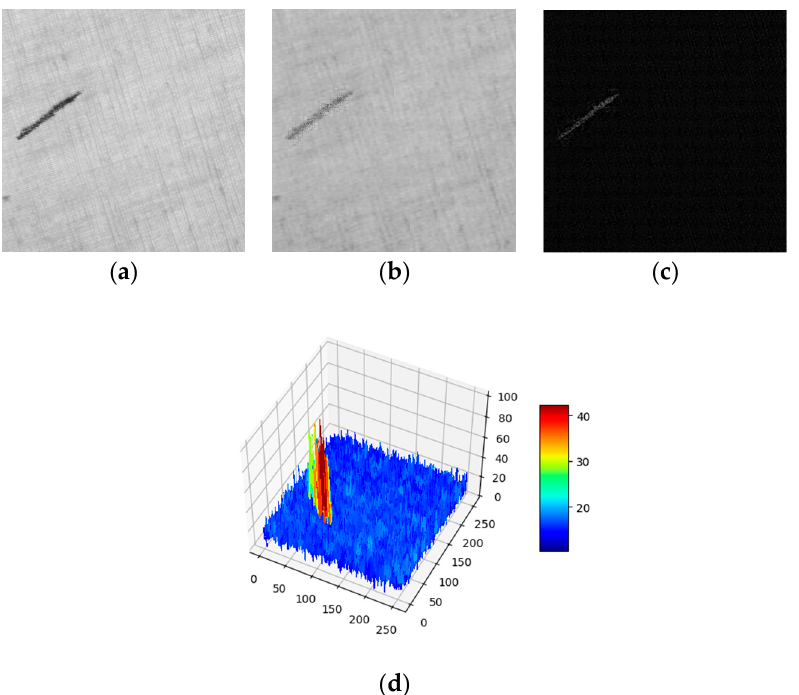
Figure 1. The different reconstruction effectiveness between defective and defect-free regions . ( a ) Original image; ( b ) Reconstructed image; ( c ) Residual image; ( d ) 3D heatmap of the residual image.